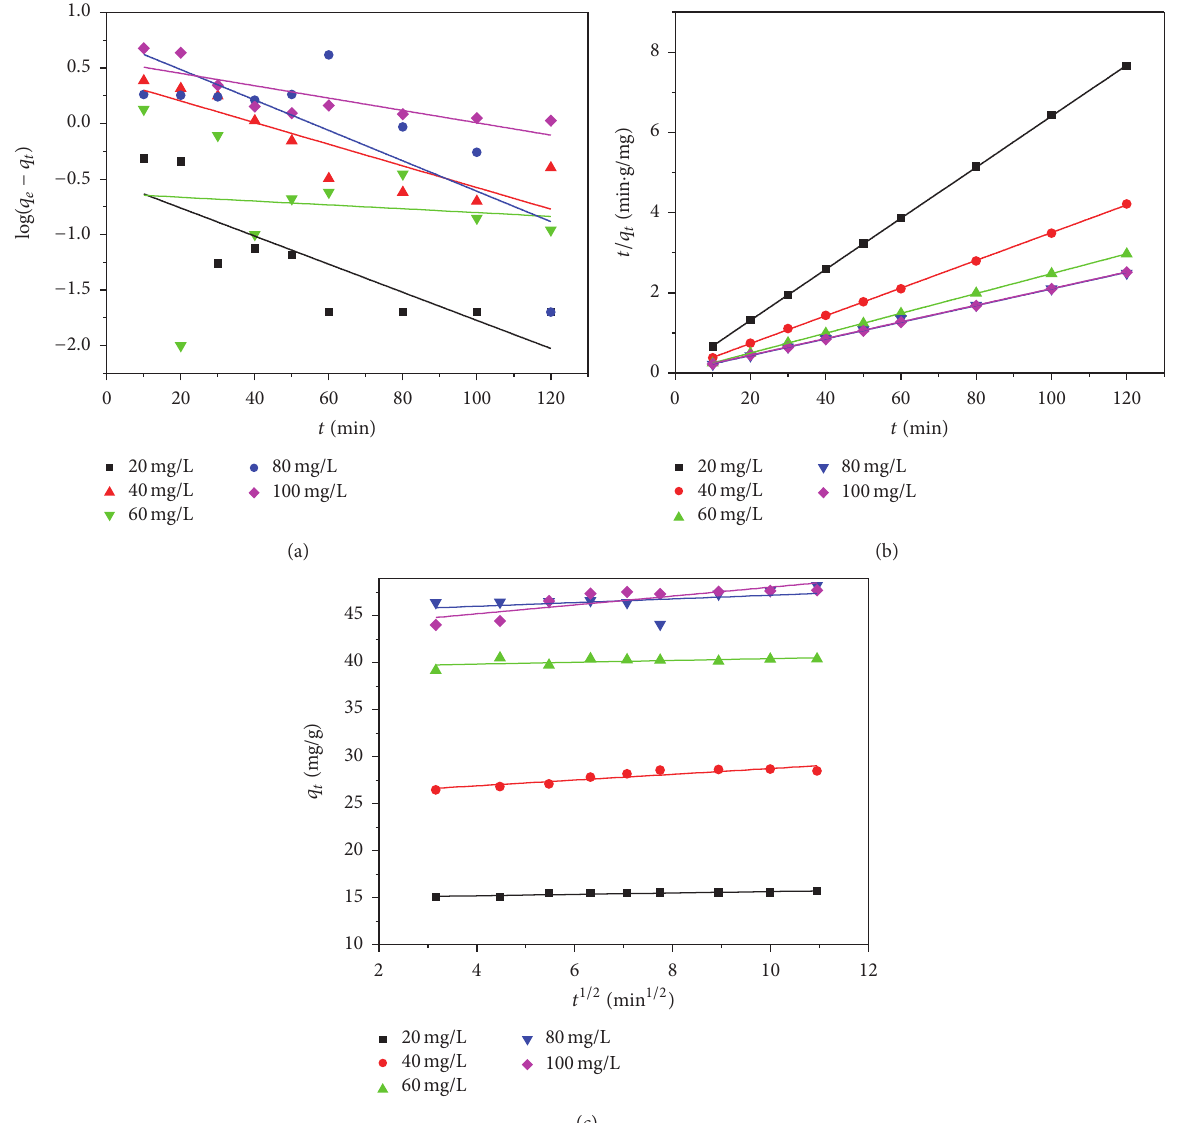
Figure5:KineticcurvesforMBadsorptiononWSatvariousdifferentconcentrations:(a)pseudo-first-ordermodel,(b)pseudo-second-order model, and (c) intraparticle diffusion of particles